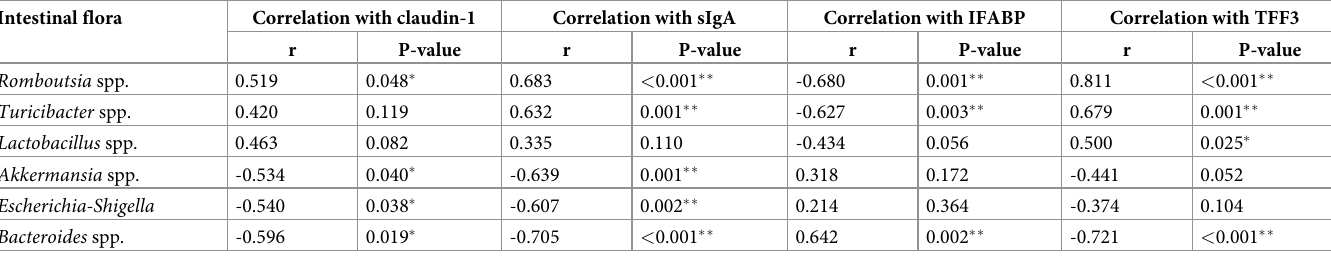
Table 3. Correlations between intestinal flora and indicators of intestinal mucosa. Intestinal flora Correlation with claudin-1 Correlation with sIgA Correlation with